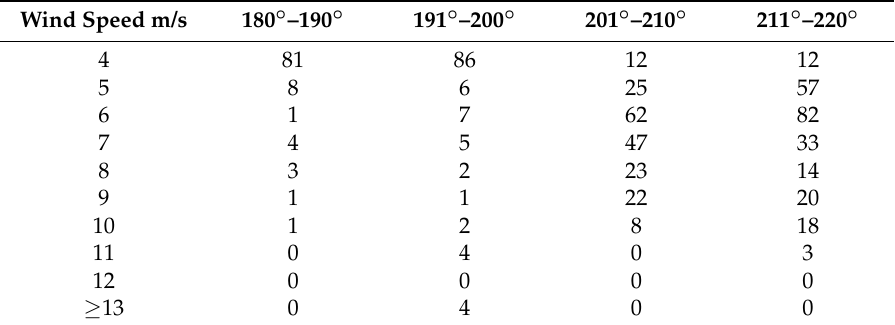
Table 2. Number of valid SCADA data points in different direction and speed bins as measured by met mast at 80 m height and wind turbines, at a 10 min interval (before